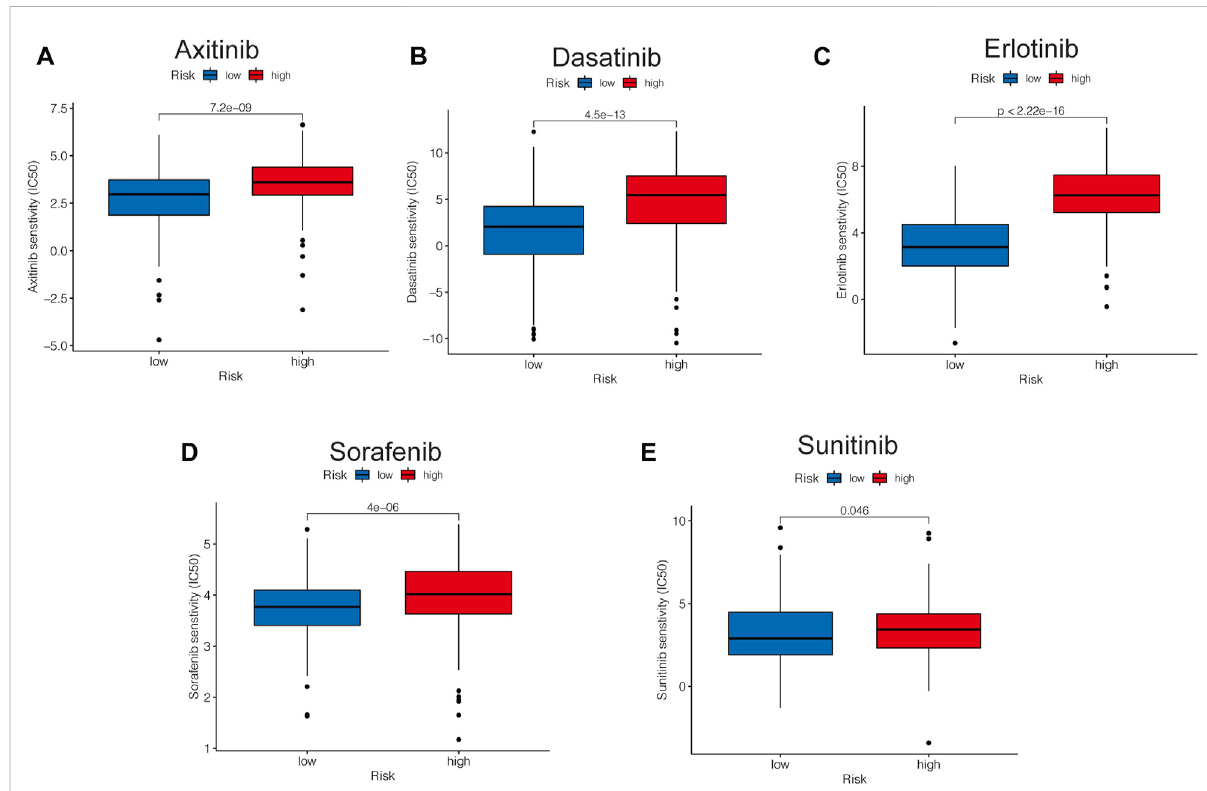
FIGURE 11 Risk-related drug-sensitivity prediction. (A – E) Relationship between risk score and chemotherapeutic